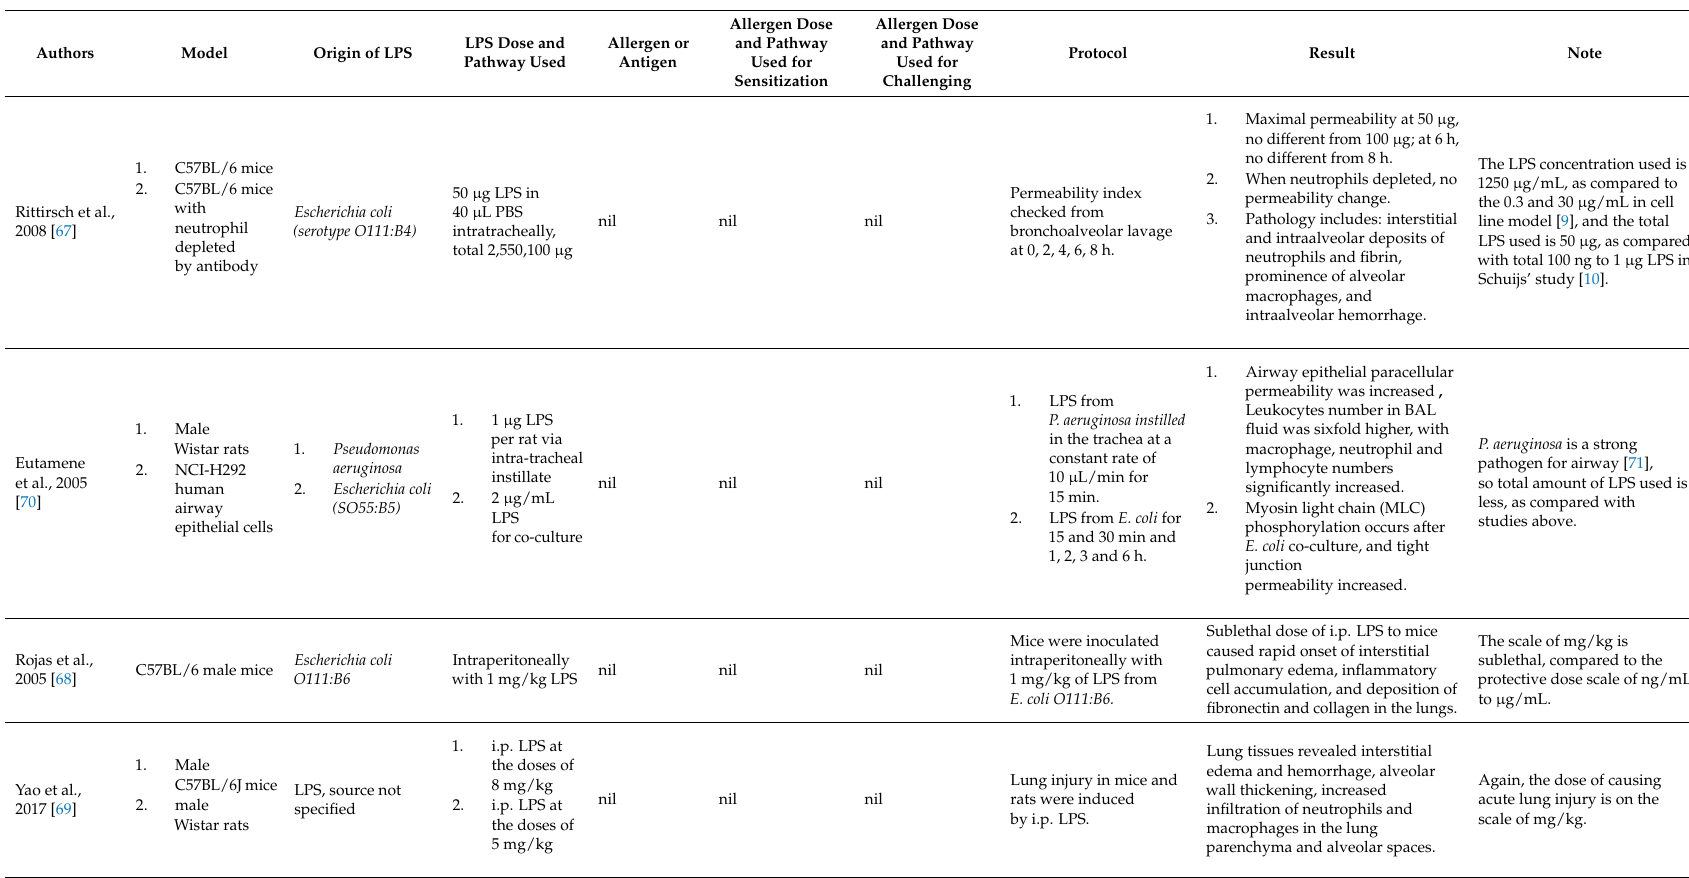
Table 3. Studies demonstrating the pro-inflammatory capacity of